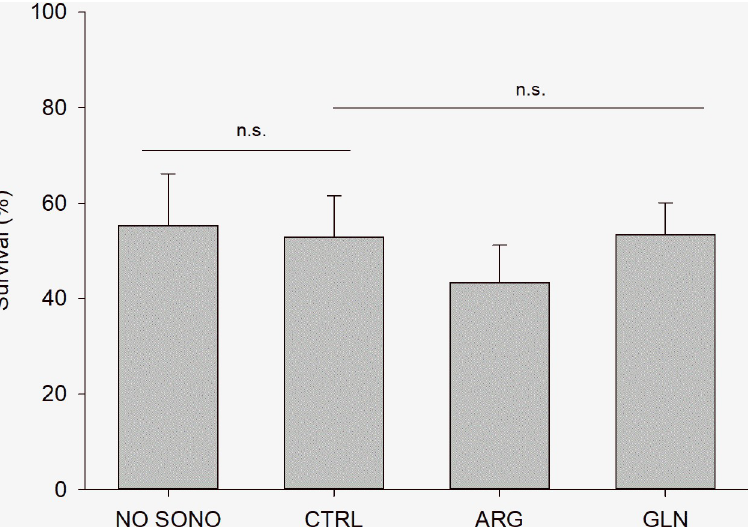
Fig 1. Zebrafish larvae survival at the end of the experiment. Survival (%) of zebrafish larvae (22 dpf) from NO SONO, CTRL, ARG and GLN treatments. Values are presented as mean ± SD. “n.s.” denotes absence of statistical difference among treatments (P > 0.05).